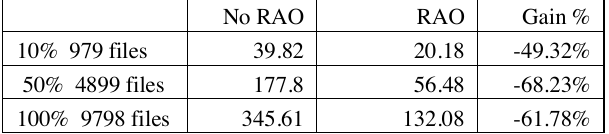
Table 6 RAO effects for small 1 GB Aggregated files